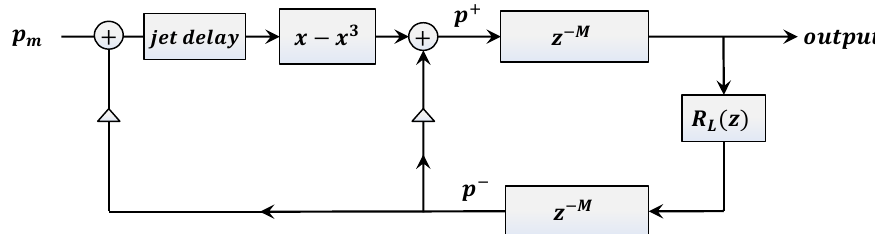
Figure 2. Block diagram of the recorder’s physical model, simulated with the Digital Waveguides Technique, based on [13–15].